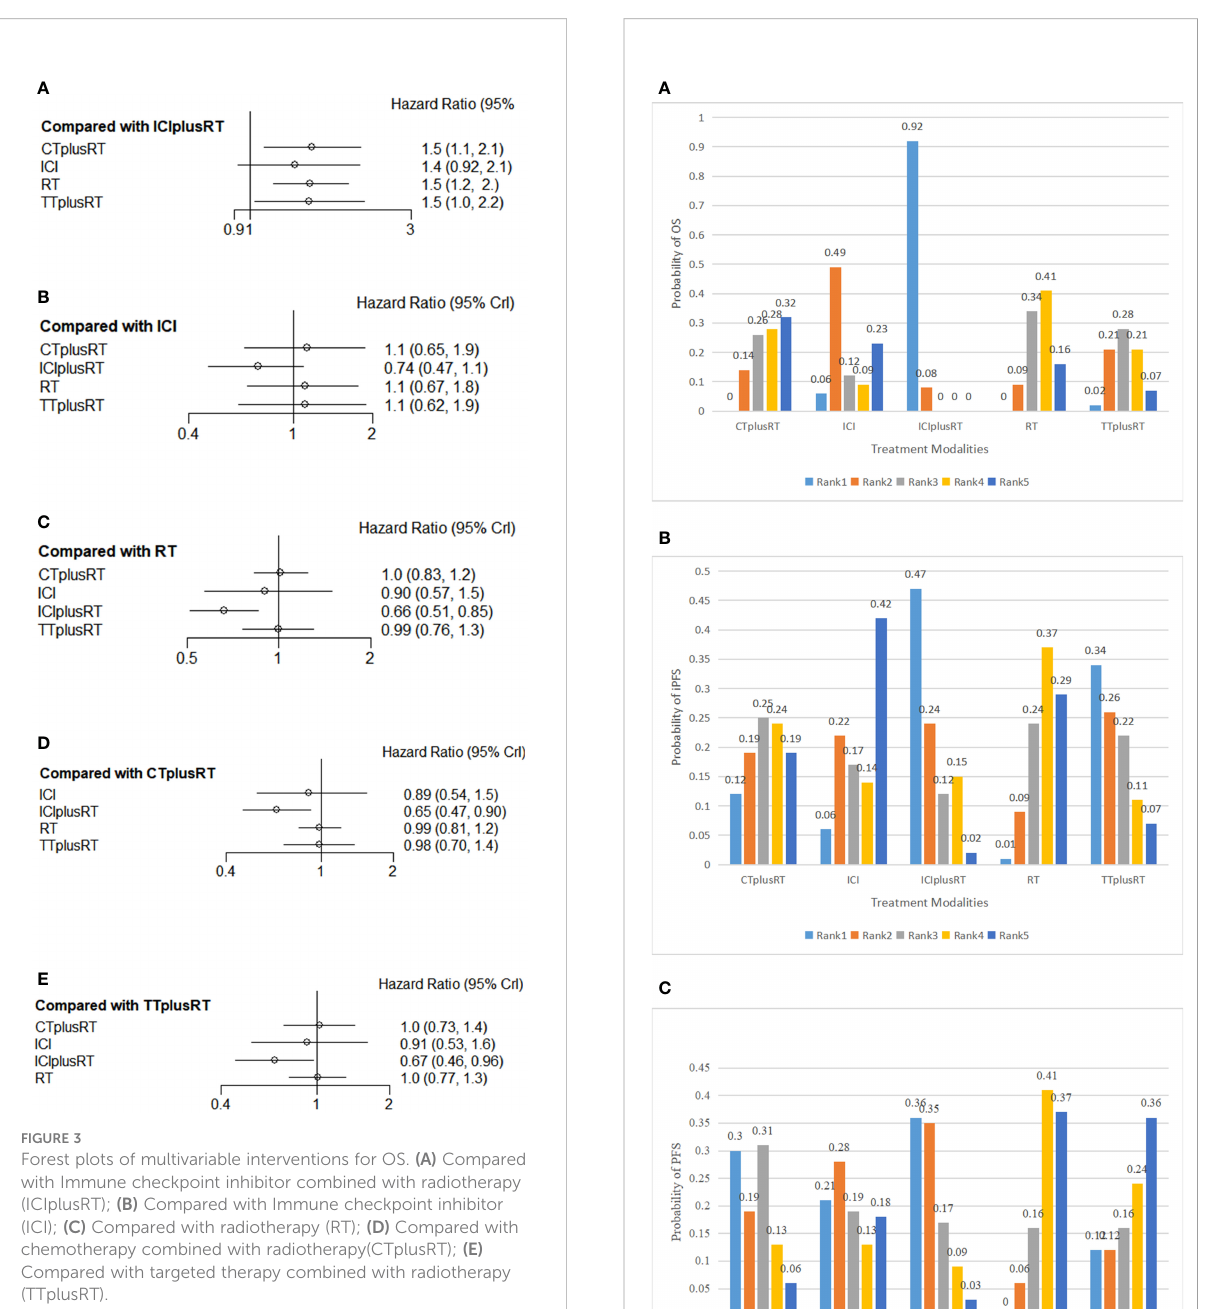
FIGURE 4 Ranking of treatments in terms of overall survival (OS), progression-free survival (PFS), and intracranial progression-free survival (iPFS). Abbreviations: CT+RT, chemotherapy combined with radiotherapy; ICI, Immune checkpoint inhibitor; ICI+RT, Immune checkpoint inhibitor combined with radiotherapy; RT, radiotherapy; TT+RT, targeted therapy combined with radiotherapy; (A) ranking of treatments to OS; (B) ranking of treatments to iPFS; (C) ranking of treatments to